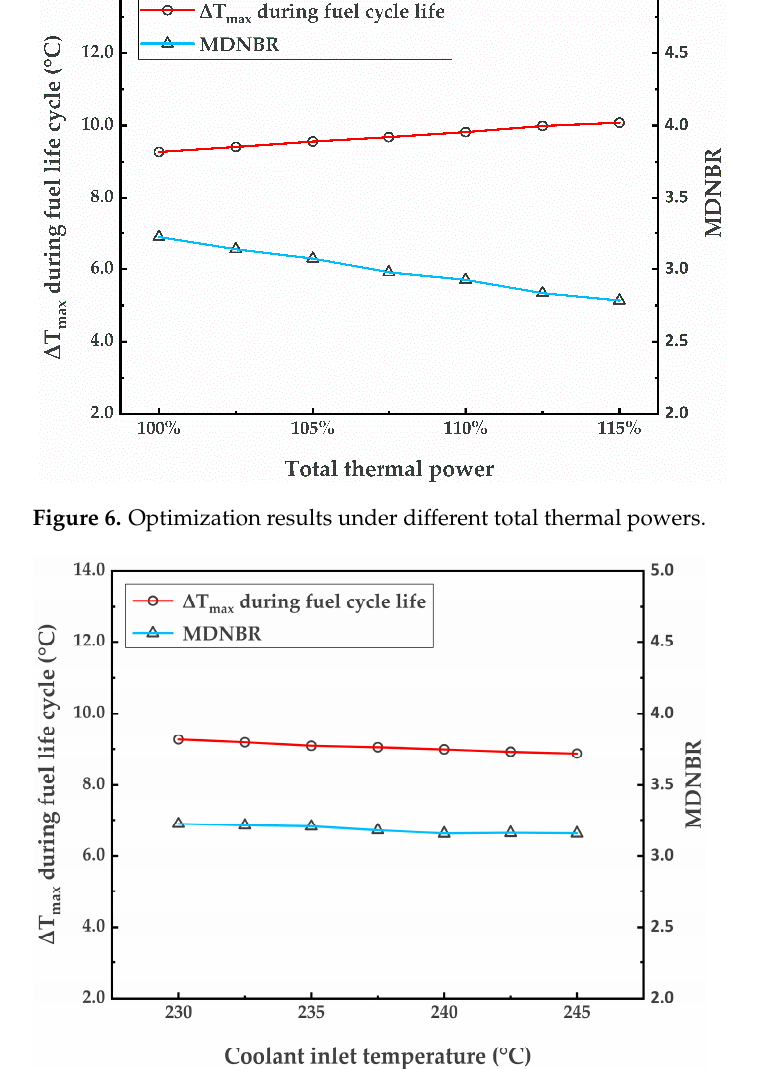
Figure 6. Optimization results under different total thermal powers.